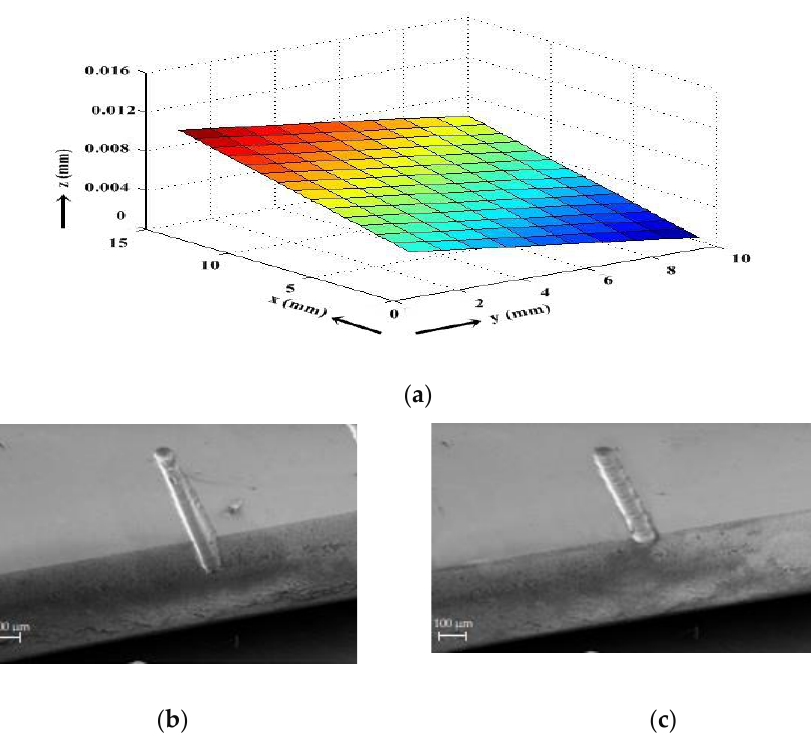
Figure 3. ( a ) The surface profile of the quartz substrate before the ‘slope correction’ process and SEM images of micro-channels fabricated ( b ) before and ( c ) after the workpiece surface slope correction.